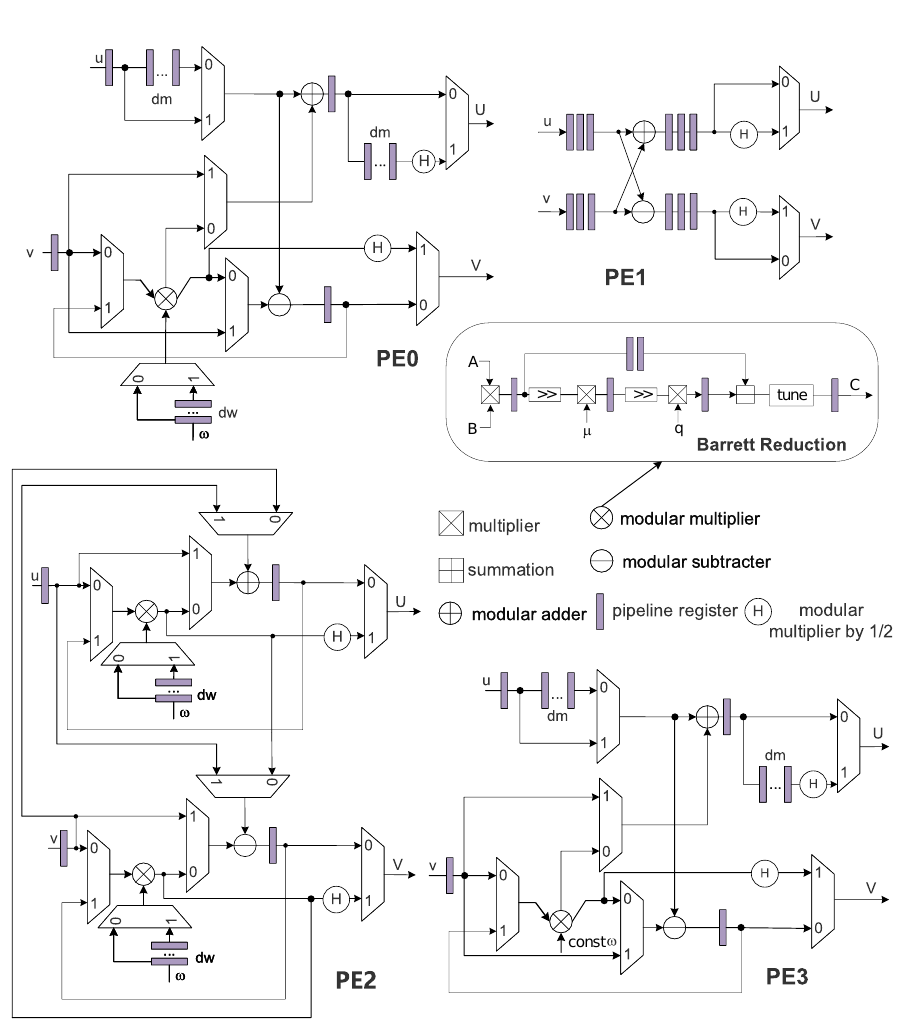
Figure 9: The compact architecture of radix-4 butterfly